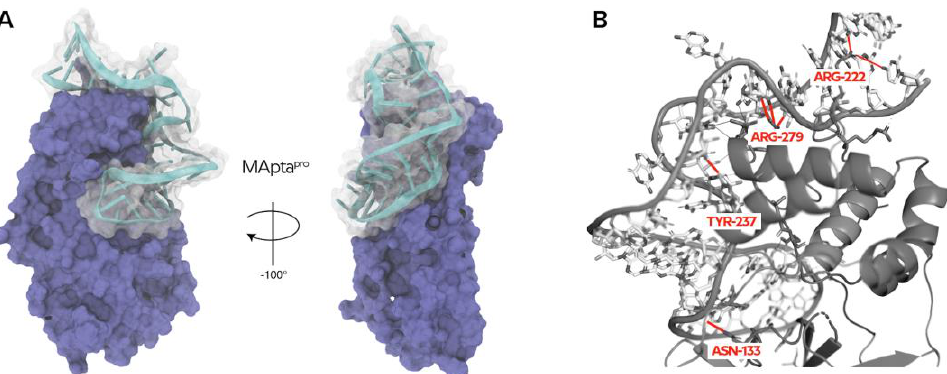
Figure 3. ( A ) VMD generated image of 3D-40mer aptamer MApta pro in complex with the protein M pro . ( B ) PyMol generated image of hydrogen bonds of the best docked pose of the selected aptamer MApta pro (for detailed interaction see Figure S1 in Supplementary file).